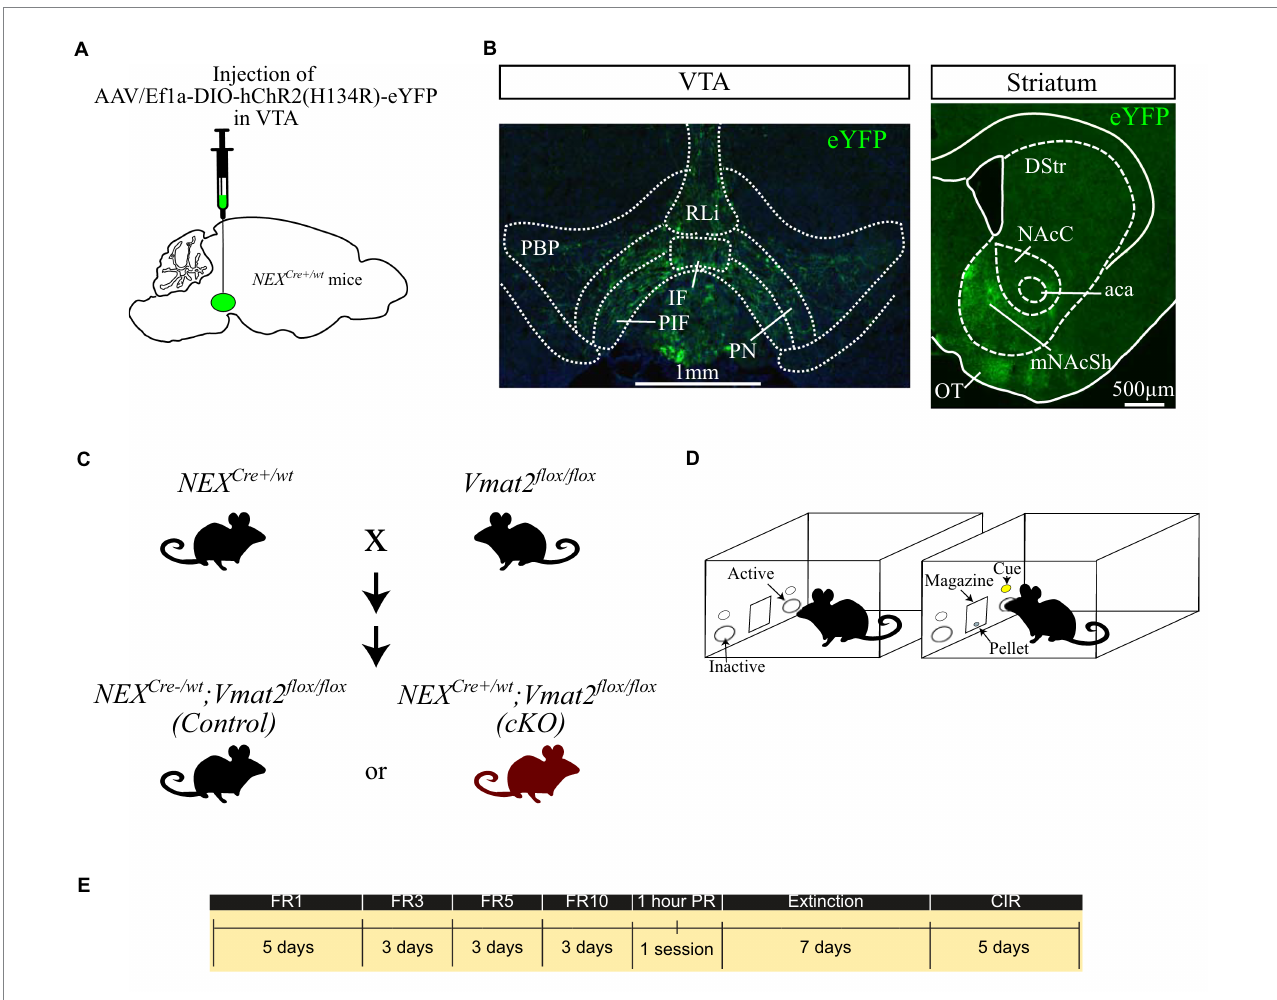
FIGURE 1 Schematic representation of the virus injection in NEX Cre+/wt mice (A) . Fluorescent images showing the distribution of NEX-Cre neurons in the VTA ( B , left panel) and their main projections to the mNAcSh ( B , right). Breeding strategy to obtain NEX Cre − /wt ;Vmat2 flox/flox (Control) and NEX Cre+/wt ; Vmat2 floxf/lox (cKO) mice (C) . Schematic of the apparatus (D) and the schedule of the behavioral experiments (E) . aca: anterior commissure, anterior part, DStr: dorsal striatum, NAcC: nucleus accumbens core, mNAcSh: nucleus accumbens medial shell, IF: interfascicular nucleus, OT: olfactory tubercule, PBP: parabranchial pigmented nucleus, PIR: parainterfascicular nucleus, PN: paranigral nucleus, RLi: rostral linear nucleus. CIR: Cue-induced